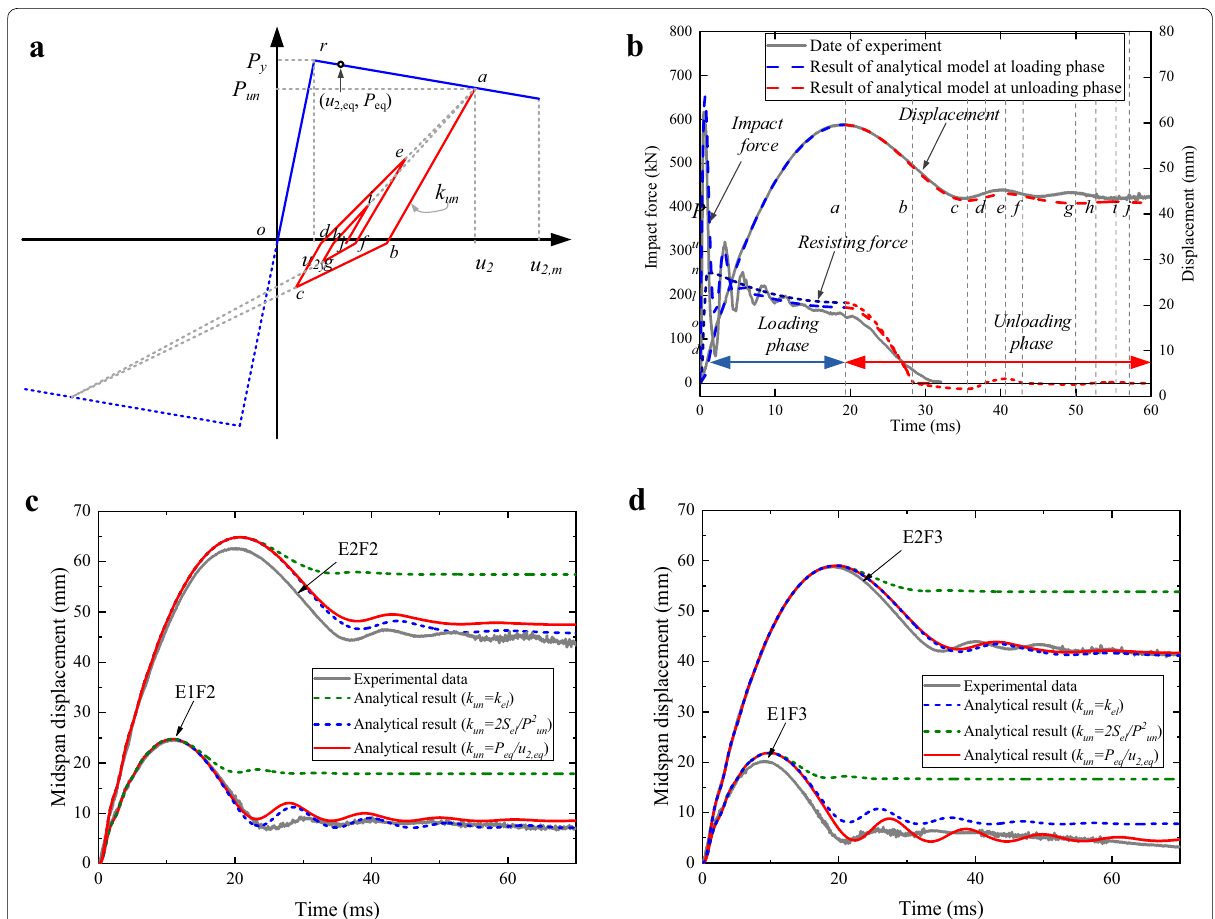
Fig. 8 a Hysteretic model of axially-loaded circular RC column; b Impact response characteristics; c Displacements of cases E1F2 and E2F2; d Displacements of cases E1F2 and